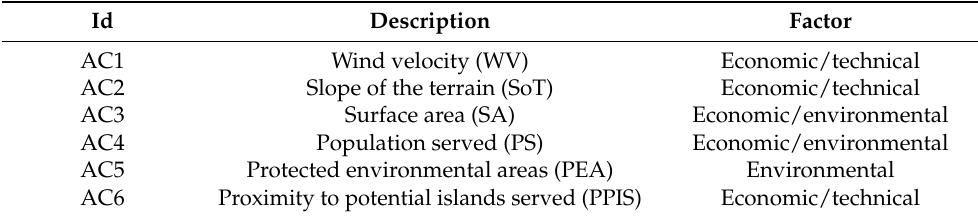
Table 2. Assessment criteria for wind farm siting on UIs in the region of the South Aegean, Greece. Id Description Factor AC1 Wind velocity (WV) Economic/technical AC2 Slope of the terrain (SoT) Economic/technical AC3 Surface area (SA) Economic/environmental AC4 Population served (PS) Economic/environmental AC5 Protected environmental areas (PEA) Environmental AC6 Proximity to potential islands served (PPIS)